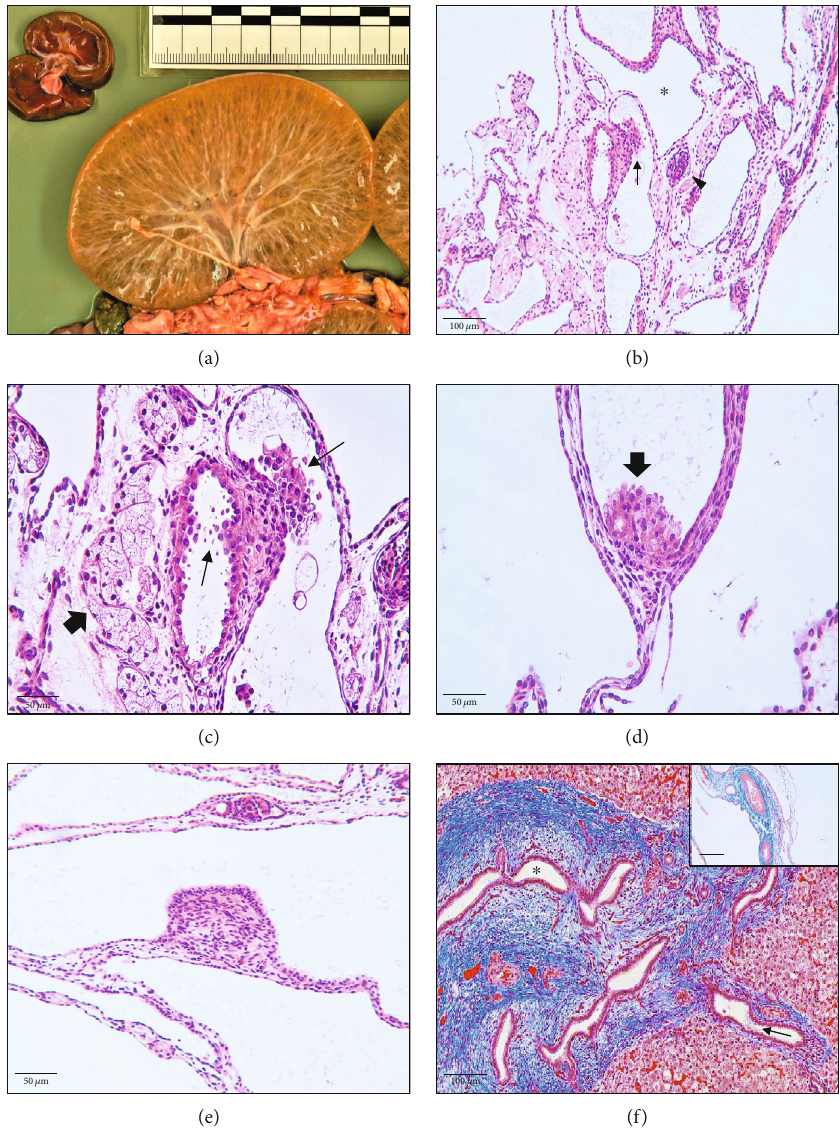
Figure 1: Macroscopic and microscopic features of renal and hepatic tissue. Kidney (a – e): (a) severe di ff use perpendicular polycystic alteration of the renal parenchyma. The discrimination of cortex and medulla fails. Normal sized twin kidney for scale (upper left corner). (b, c) Polycystic alteration of the renal parenchyma (asterisk) is lined by a fl attened epithelium. Multifocal polypoid proliferates/projections of the tubular epithelium can be seen (thin arrows). Furthermore, there are single morphologically matured glomeruli (arrowhead). The interstitial tissue is characterized by a delicate fi brovascular stroma, blood vessels, and numerous atrophic/necrotic tubules (thick arrow). Hematoxylin and eosin (HE) (d) polypoid proliferates/projections (arrow) consist of protruding round to ovoid cells, occasionally occurring with a foamy/vacuolated pale eosinophilic cytoplasm. HE (e) fi brous protrusion lined by isoprismatic epithelium is obvious. HE. Liver: (f) multifocal proliferated and dilated biliary ducts (asterisk), surrounded by marked pericholangiolar bridging fi brosis (green). Occasionally, supraepithelial granular structures can be seen (arrow). Numerous blood vessels occur with a marked perivascular fi brosis (inset). Masson ’ s